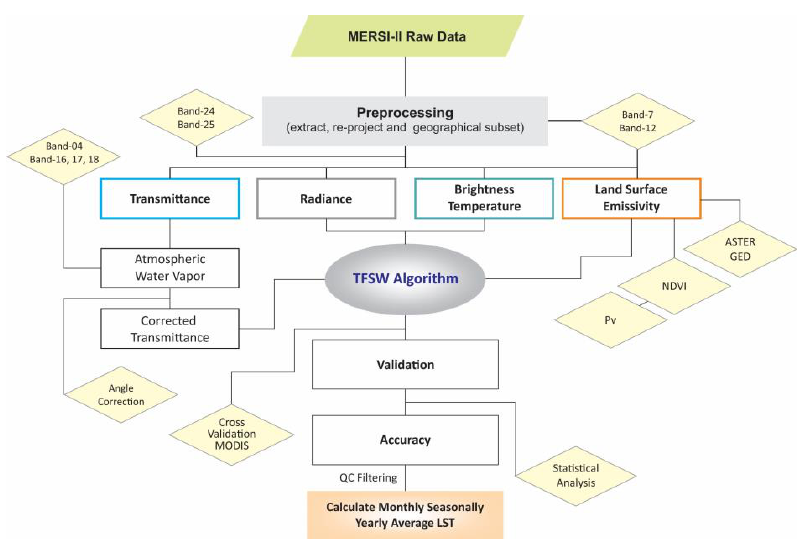
Figure 3. The framework depicting the phases required for LST estimation and spatiotemporal anal- ysis.